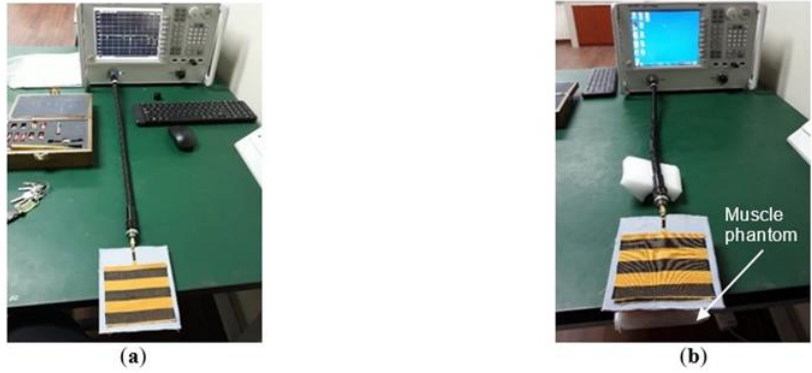
Figure 9. Measurement setup for return loss ( S 11 ): ( a ) In free space (Case A); ( b ) In the presence of the muscle phantom (Case B). Materials 2019 , 12 , x FOR PEER REVIEW